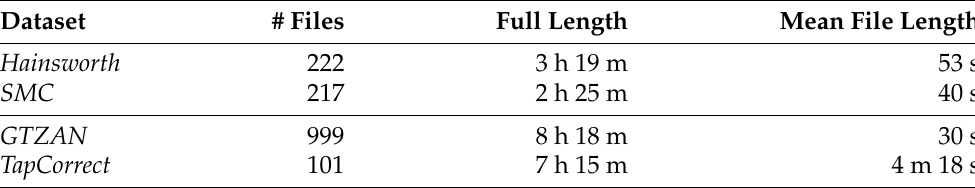
Table 1. Overview of the datasets used for the evaluation.